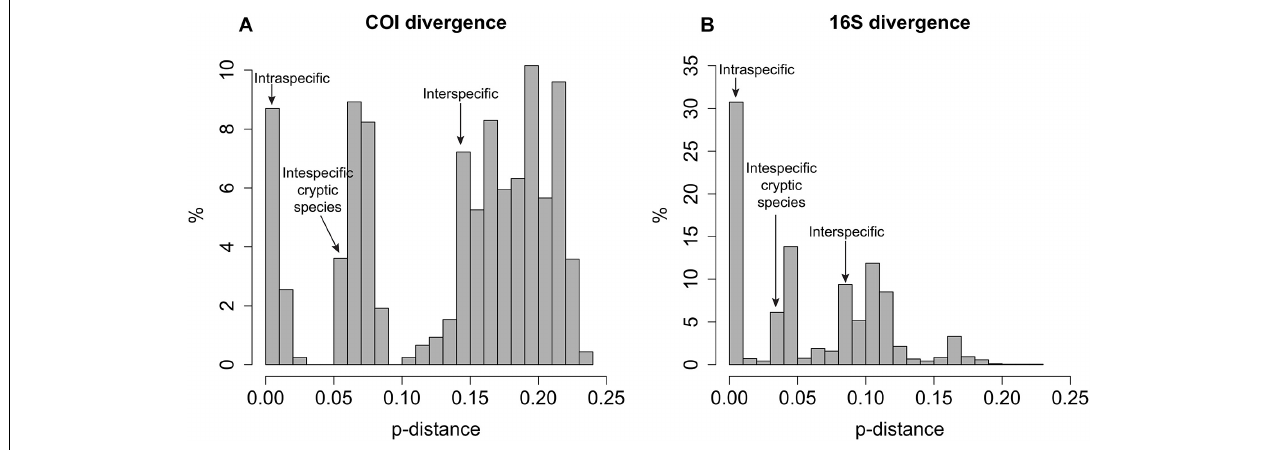
FIGURE 1 | Histogram of p-distances for (A) COI and (B) 16S